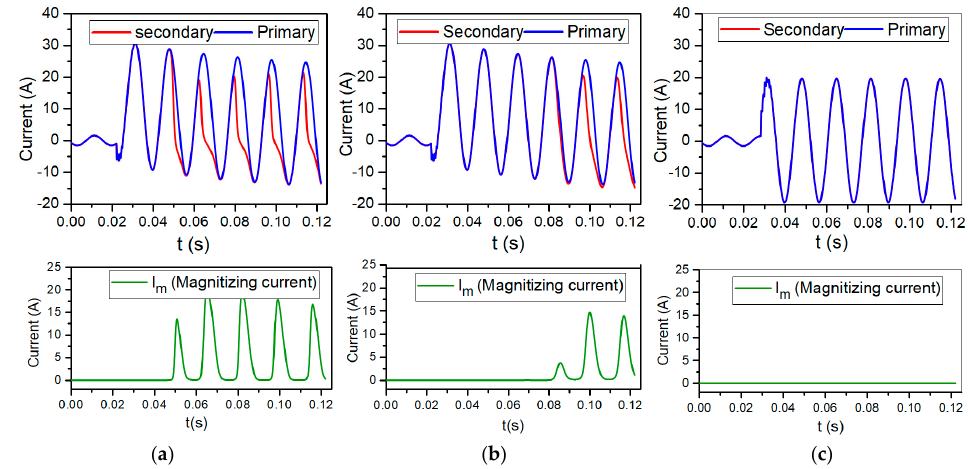
Figure 3. Different levels of the current transformer (CT) saturation obtained from simulation results: ( a ) Heavy Saturation; ( b ) Light Saturation; ( c ) No Saturation.